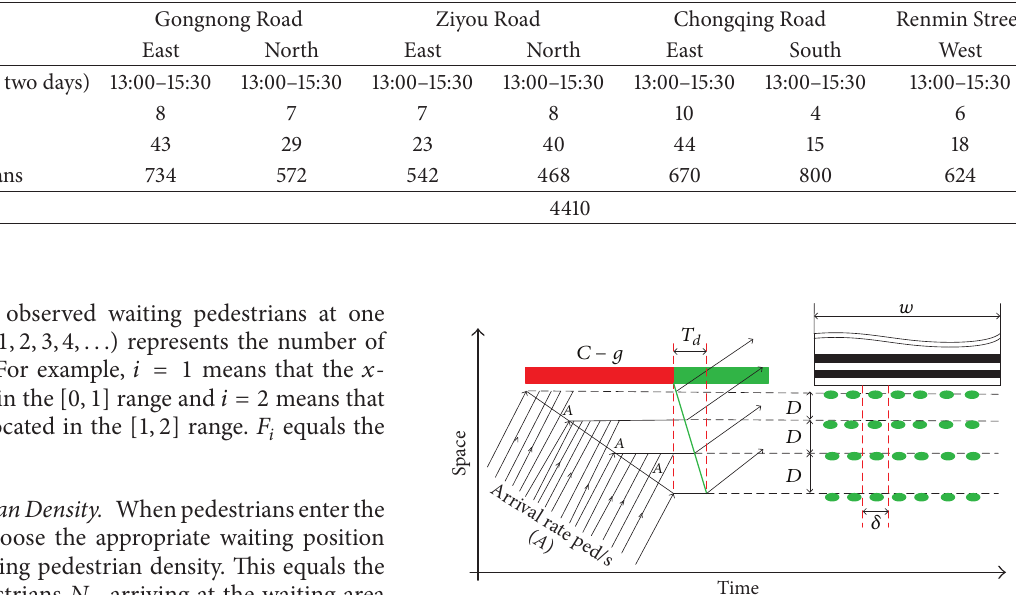
Table 1: Geometric characteristics of study sites.